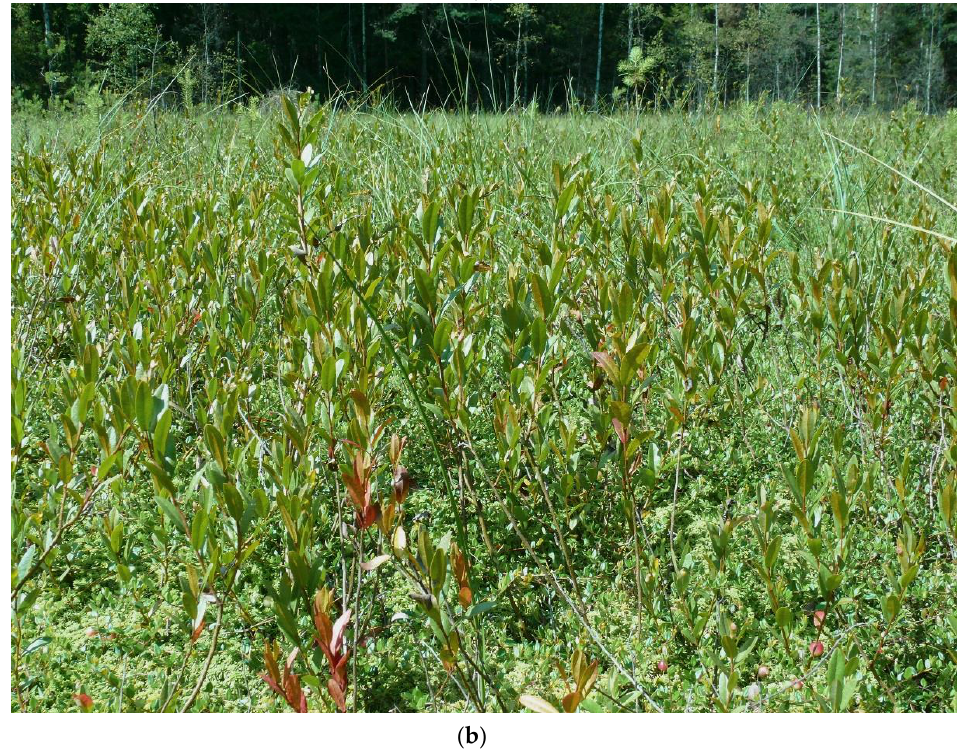
Figure 4. Population area of Chamaedaphne calyculata at the new site near Nerwik village. ( a ) Immediate surroundings (March). ( b ) Part of the studied population (August).